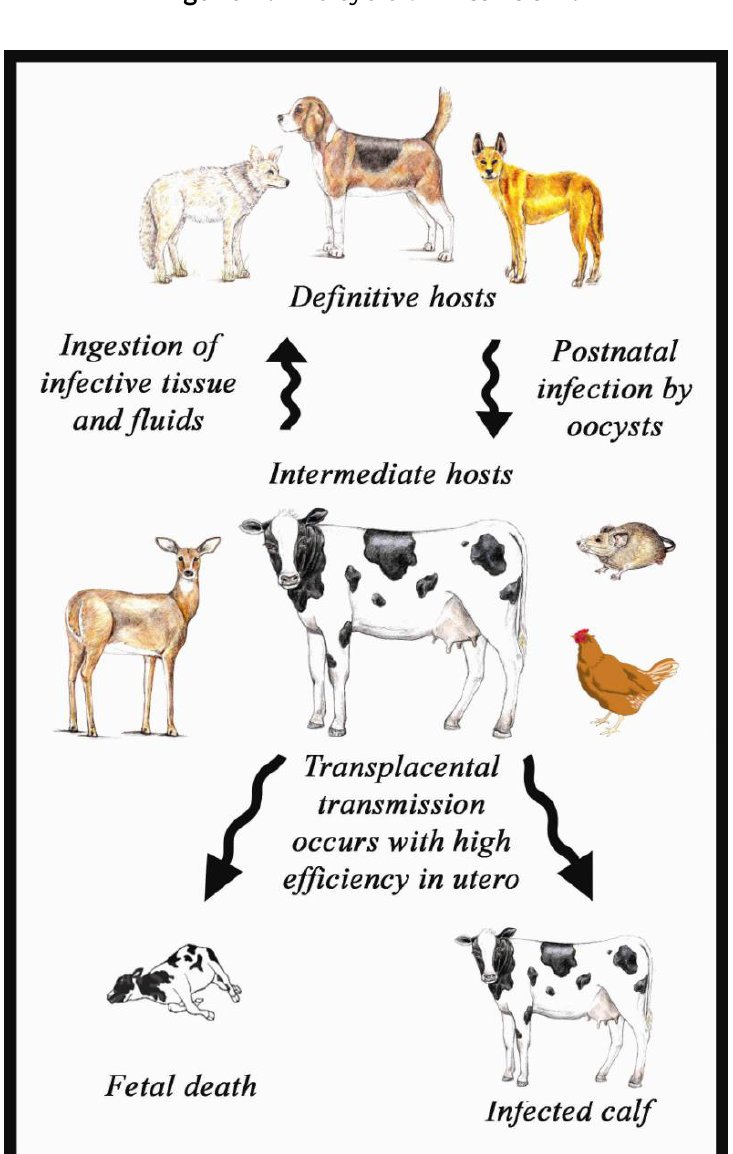
Figure 1. Life cycle of N